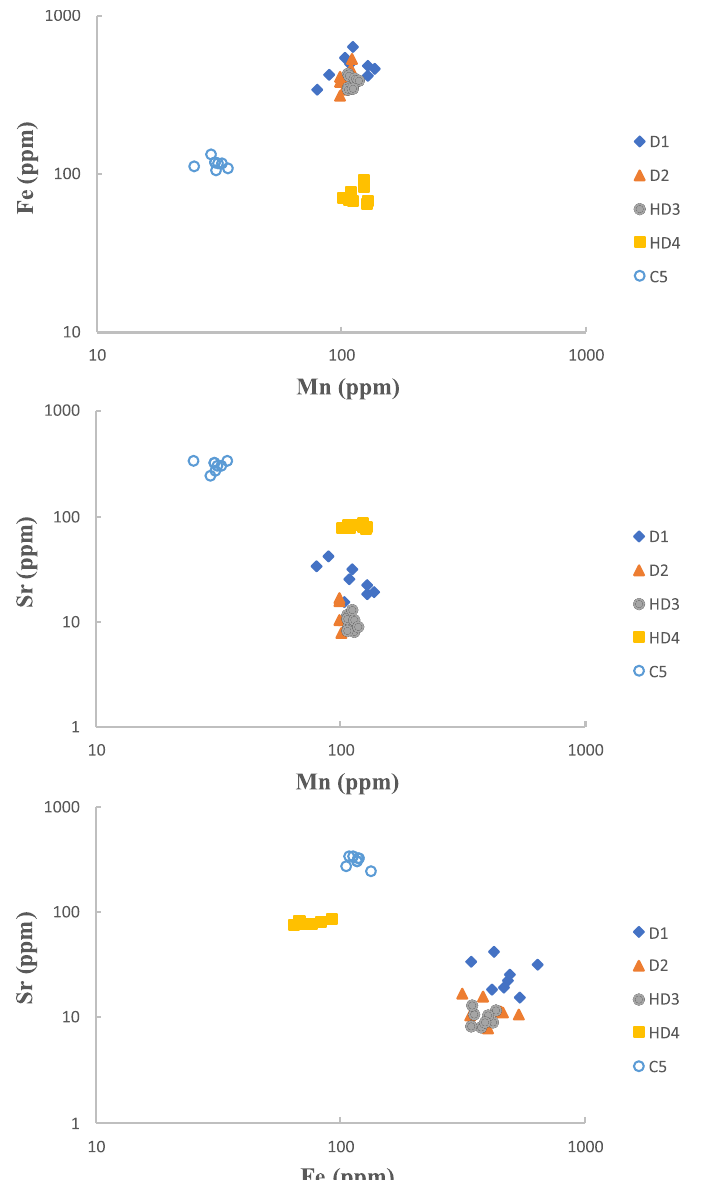
18 of 23 Figure 10. Chondrite-normalized REE patterns of dolomites from the Fuli Pb-Zn deposit (normali- zation values after Sun & McDonough [62]). As shown in Figure 11, the D1 and D2 dolomites of the Fuli deposit are enriched in Fe and Mn. Moving from the HD3 grey hydrothermal dolomite to the HD4 white hydro- thermal dolomite, Fe and Mn show a downward trend. Fe and Mn entered the carbonate in an alkaline environment, whereas Fe and Mn were released into the fluid in an acidic environment . Thus, as the metasomatism changed from strong to weak, the ore-forming